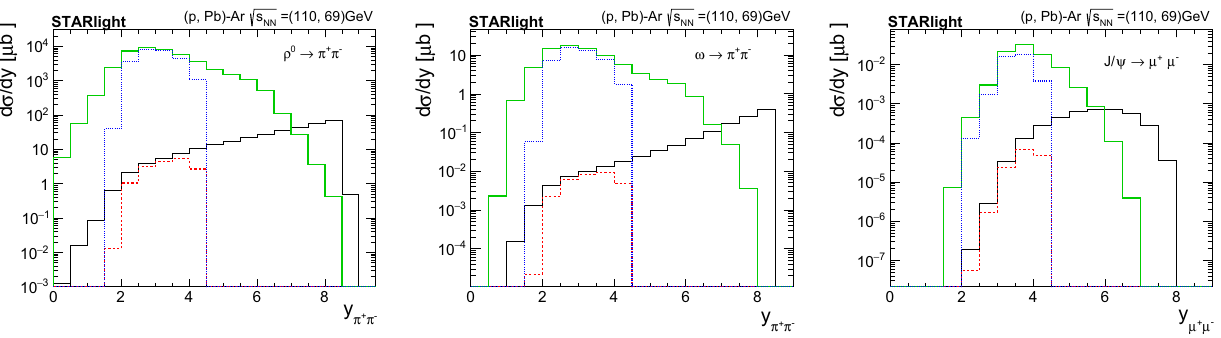
√ s = 110 and 69 GeV,